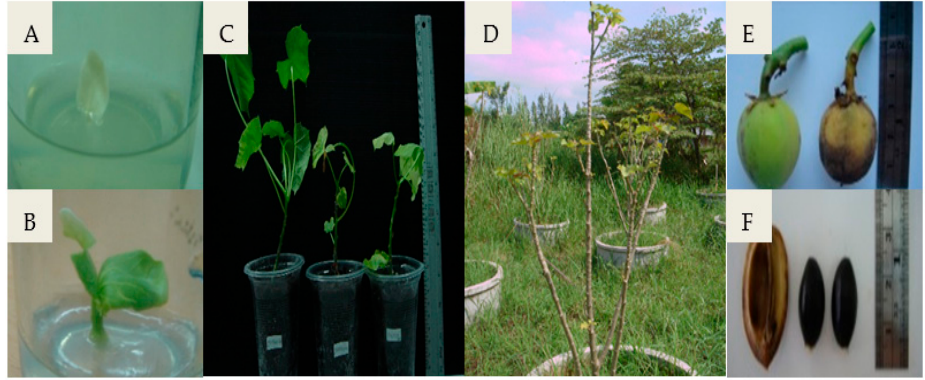
Figure 2. Development of intergeneric F 1 hybrid from the cross between J . curcas L. ( ♀ ) and R . communis L. ( ♂ ), ( A ) embryo rescue, ( B ) three-day-old F 1 hybrid, ( C ) transfer of F 1 hybrid to small plastic pots containing sterile peat moss, ( D ) intergeneric hybrid plants in the field, ( E ) fruits, and ( F ) seeds.